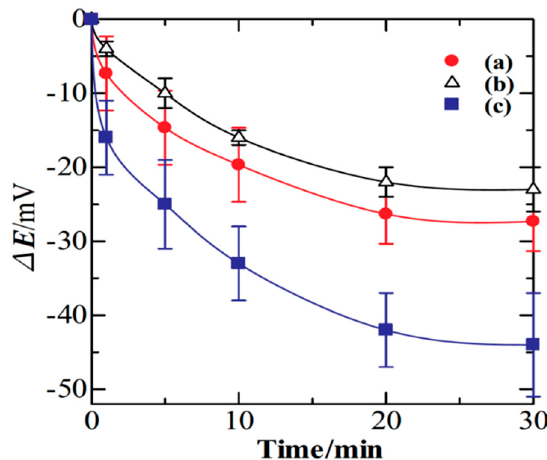
Figure 6. Time dependence of the potential change for a CP/POM electrode in the presence of 0.1 mM solutions of different antioxidants (a–c) [35]. Reprinted from J. Electroanal. Chem. , Vol. 828, Y. Tanaka,